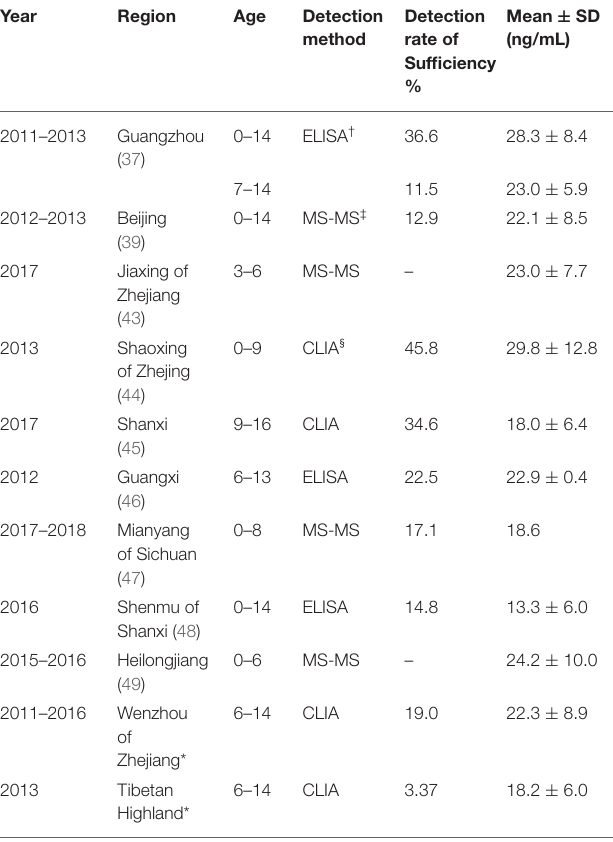
TABLE 3 | Children’s vitamin D level in different regions of